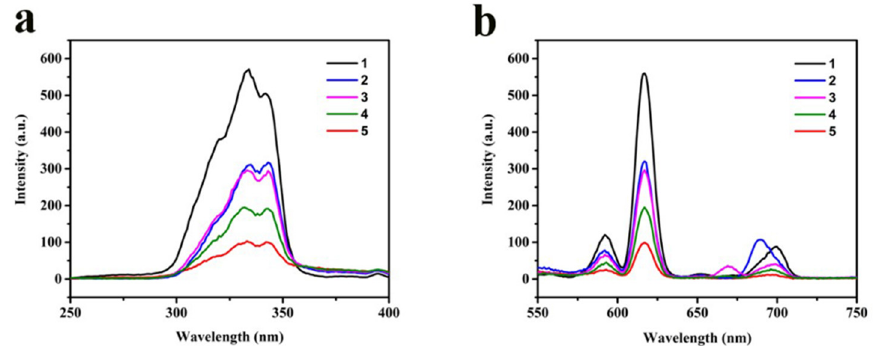
Figure 3. ( a ) Excitation spectra and ( b ) emission spectra of OEu 3+ Phen complexes in DMF solutions. The concentrations of oleic acid from spectra #1 to #5 were 0.02, 0.04, 0.05, 0.06, and 0.08 mol L − 1 ,